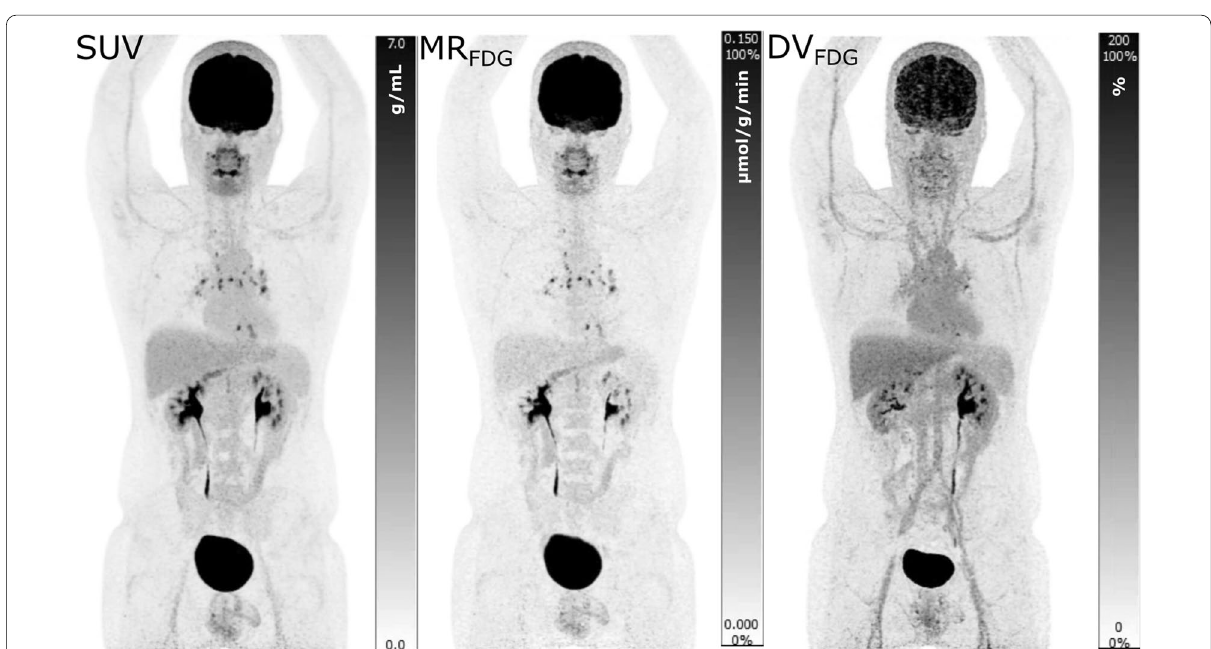
Fig. 1 Example of SUV and Patlak images analysed in our study. In this case, a 34-year-old man with mediastinal sarcoidosis. Left column: static SUV images; Middle column: MR FDG images; right column: DV FDG images. The actual FDG uptake in the inflammatory sarcoid lymph nodes is evident on the MR FDG image, whereas the free FDG in the circulation is clearly visible on the DV FDG